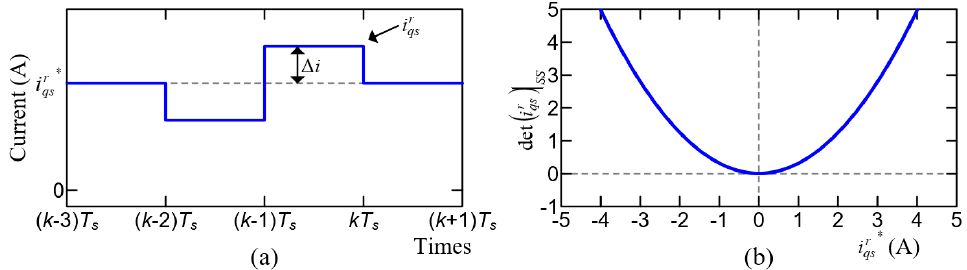
(cid:17)(cid:12) ( ) (cid:16) (cid:12) (cid:12) i r qs SSr (cid:12) qs i det versus current SS